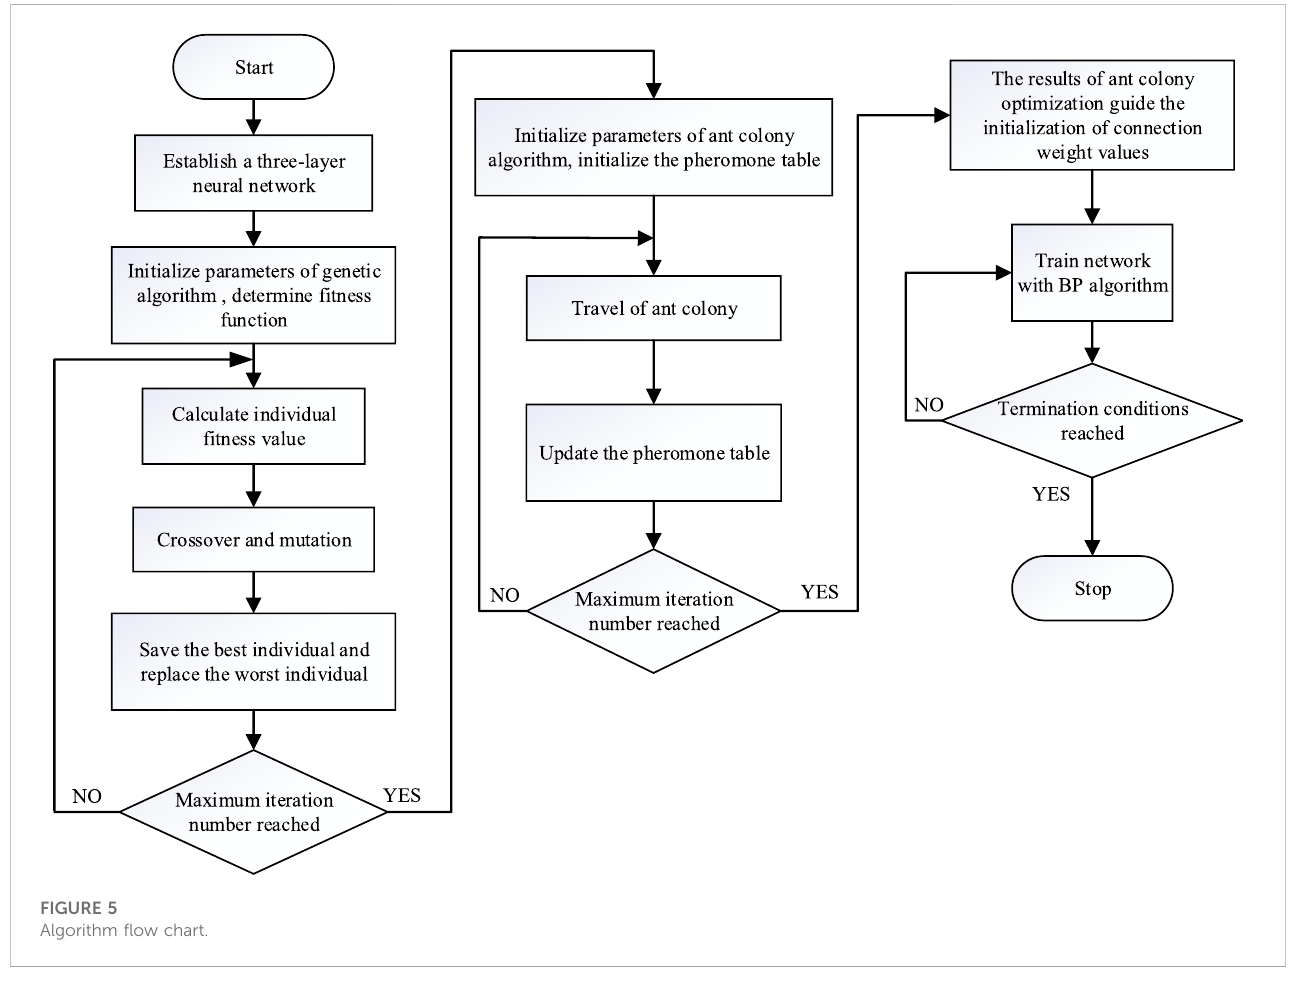
FIGURE 5 Algorithm fl ow